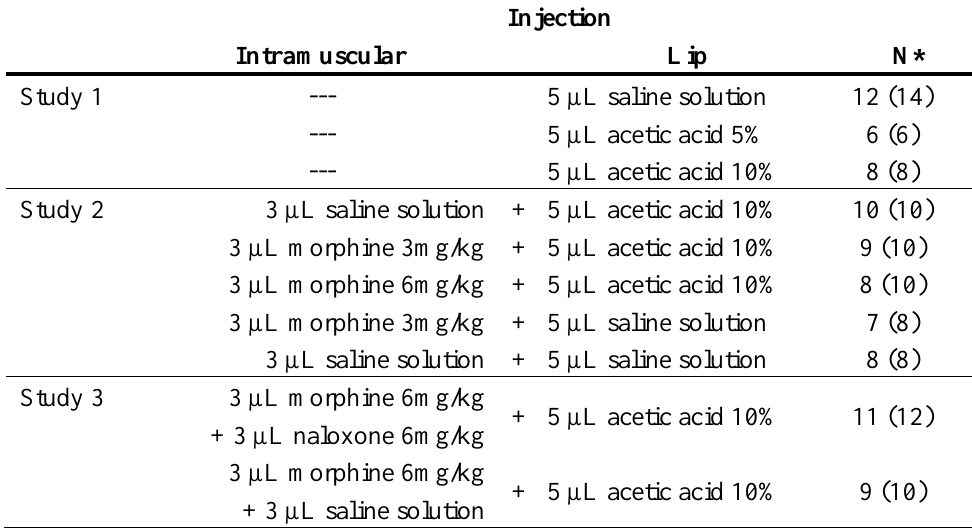
Table 1. Dosing schemes used with the automatic recording system (MOBS). * N = number of fish used for data analysis, in brackets number